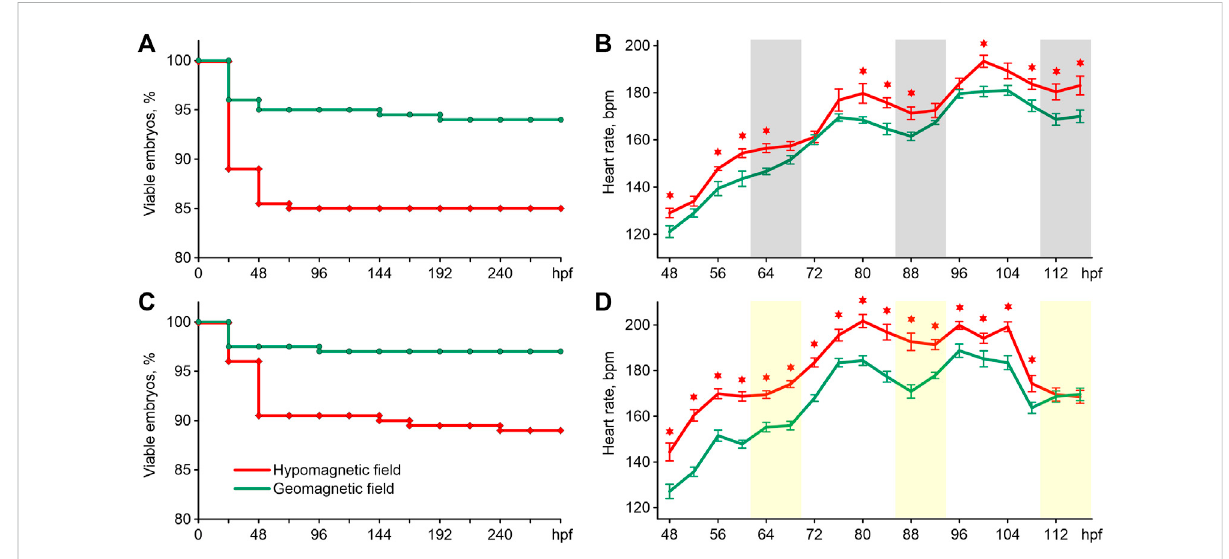
FIGURE 2 Survival curves (A) and an average heartbeat rate (B) in zebra fi sh exposed to hypomagnetic fi eld and the geomagnetic fi eld in the fi rst experiment, and survival curves (C) and an average heartbeat rate (D) in zebra fi sh exposed to HMF and the geomagnetic fi eld in the second experiment. Error bars represent standard errors. The asterisks indicate signi fi cant differences (t-test, p < 0.05). Gray bars represent the dark phase, and the light bars are the expected dark phase under constant illumination. Hpf – hours post fertilization; bpm – beats per minute.